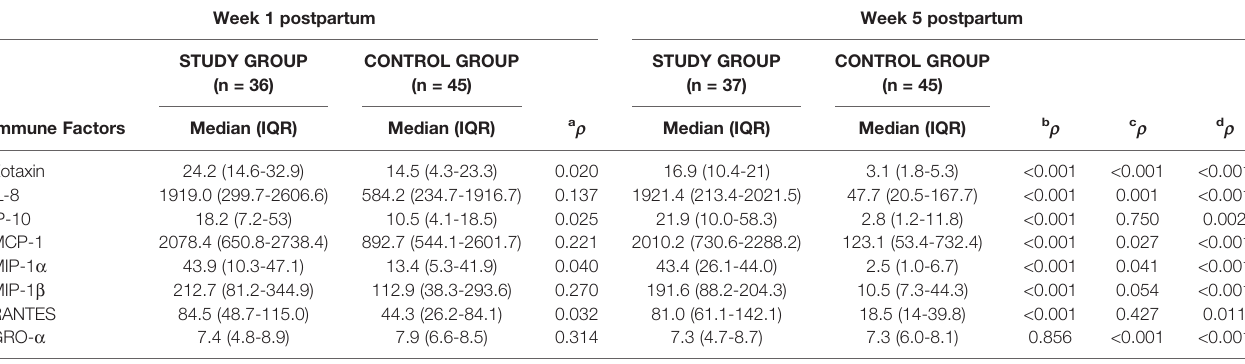
TABLE 2 | Concentration* of chemokines in milk samples of study group and control group women over